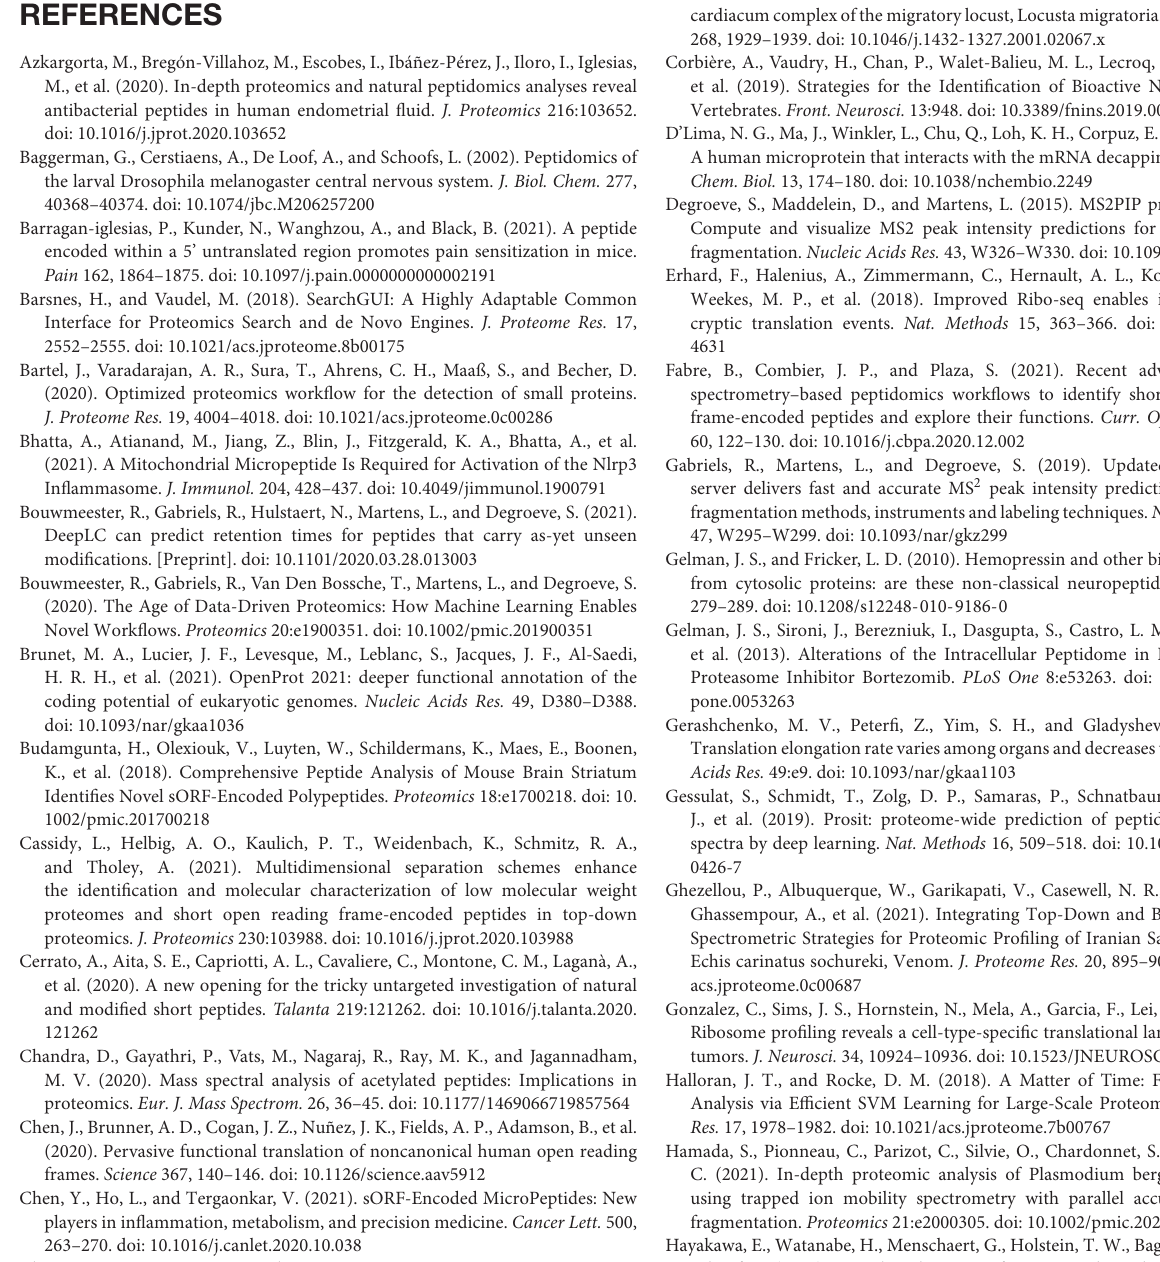
used in this study for b and y-ions combined (A) , only y-ions (B) and only b-ions (C) . Supplementary Figure 9 | Evaluation of peptide of lengths and charge. Boxplots of the Pearson Correlation Coefficient for the different MS 2 PIP models. Supplementary Table 1 | Summary Search Results. Supplementary Table 2 | Neuropeptides identifications. Supplementary Table 3 | sORFs